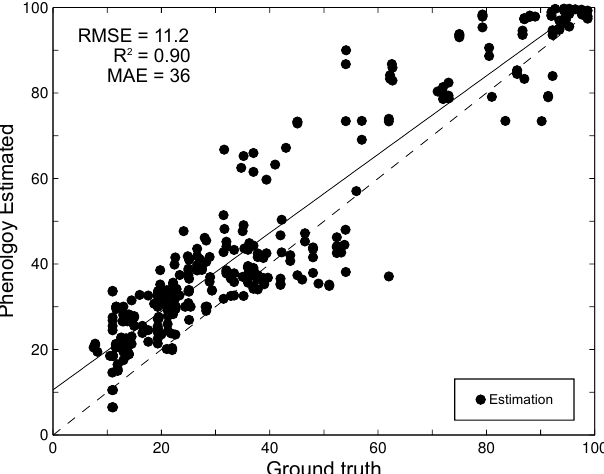
Figure 9. Phenological state estimates and ground truth for all parcels and available images with development faster than normal (120 days